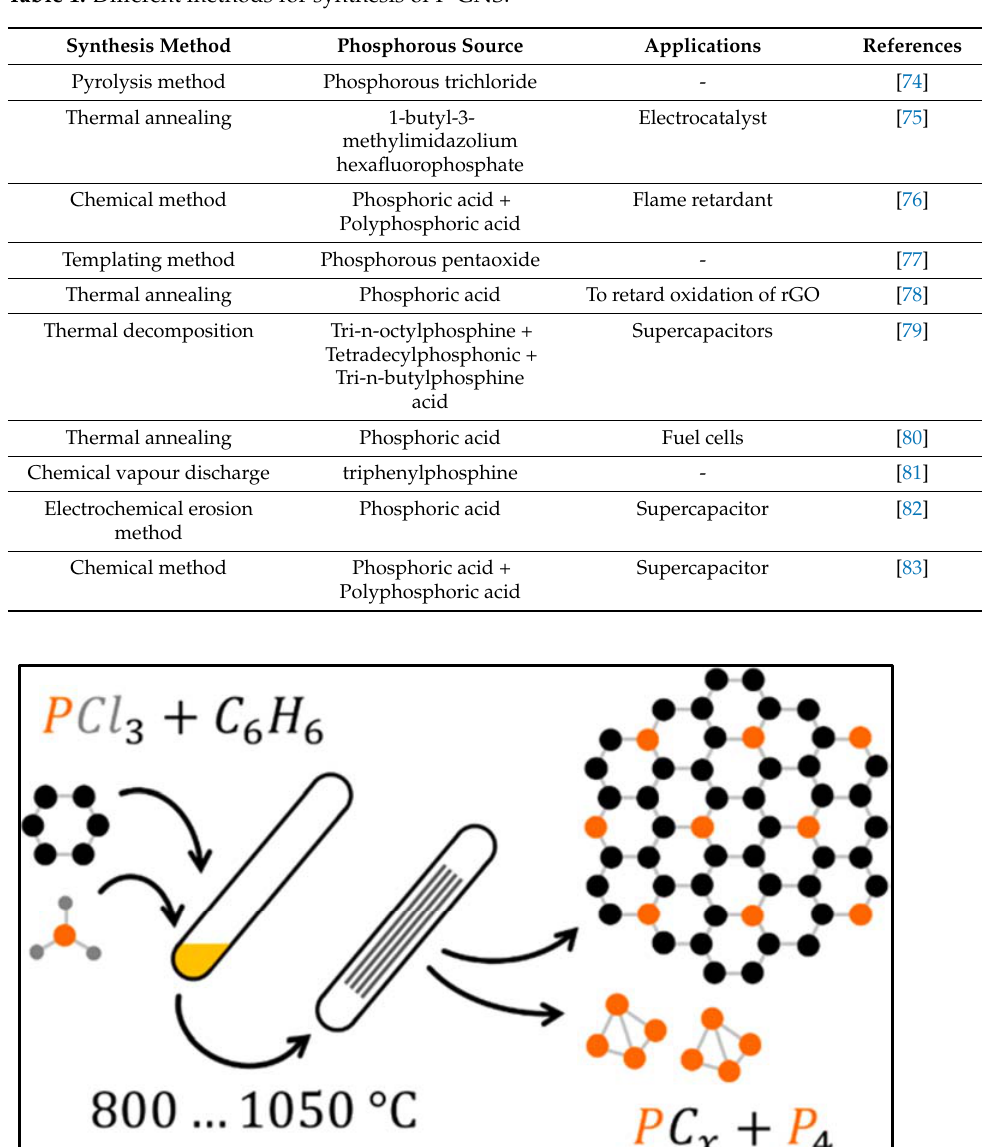
Table 1. Different methods for synthesis of P-GNS.